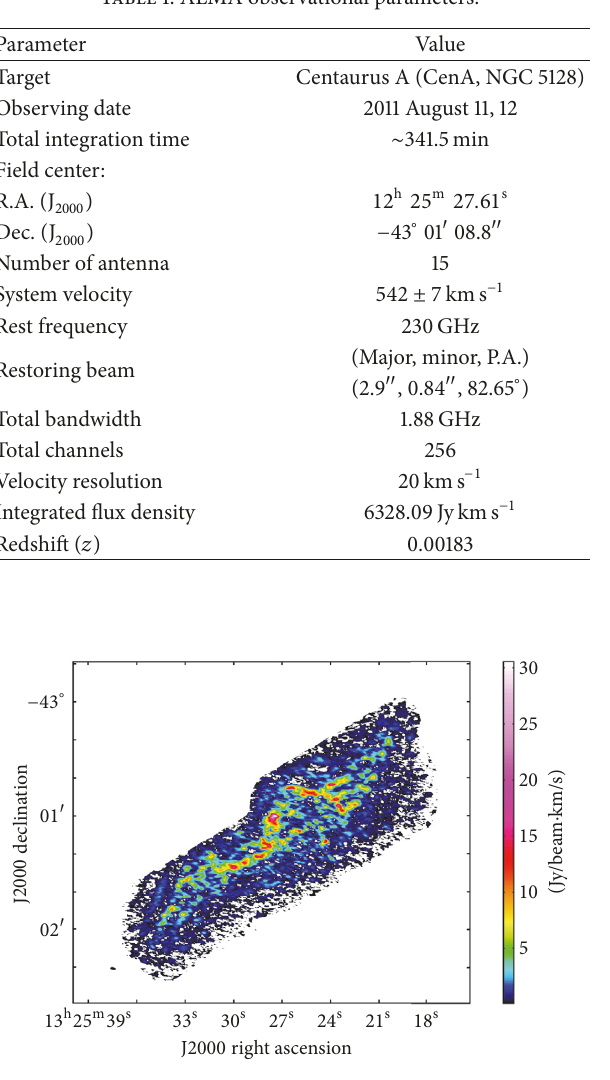
Table 1: ALMA observational parameters.